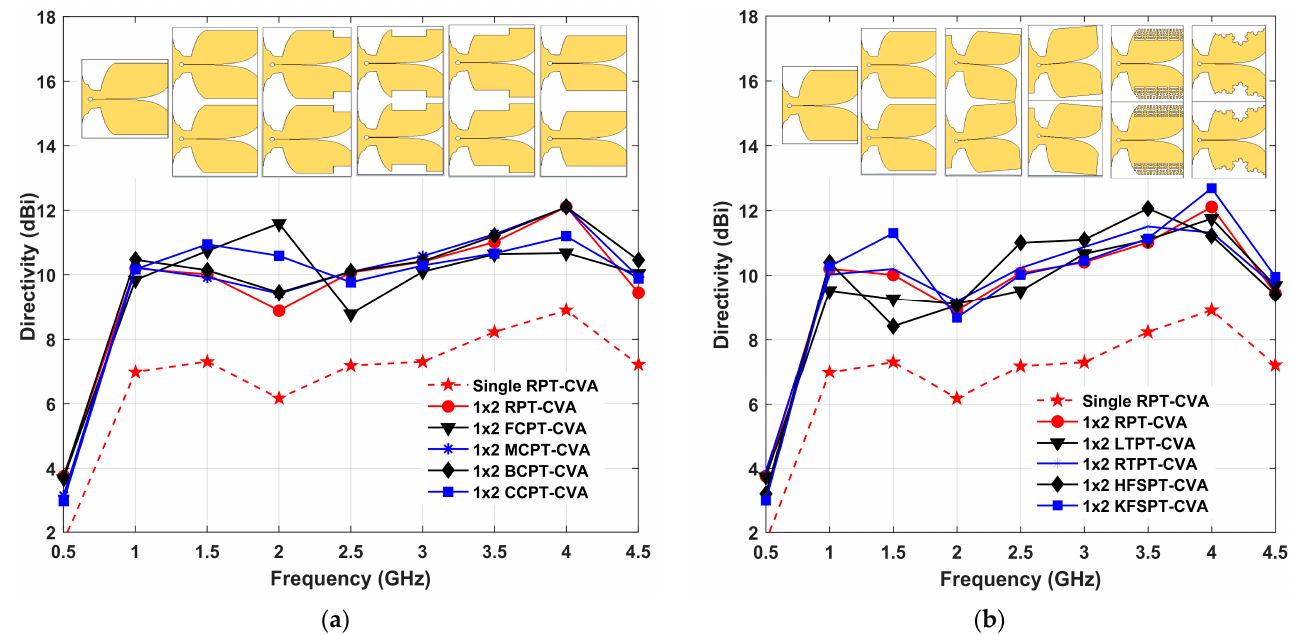
Figure 6. Directivity of: ( a ). Single and 1 × 2 Regular Palm Tree (RPT – CVA), 1 × 2Front Cut Palm Tree (FCPT–CVA), 1 × 2 Middle Cut Palm Tree (MCPT–CVA), 1 × 2 Back Cut Palm Tree (BCPT – CVA), 1 × 2 Complete Cut Palm Tree (CCPT–CVA) and ( b ). Single and 1 × 2 of Regular Palm Tree (RPT – CVA), 1 × 2 Left Tilt Palm Tree (LTPT–CVA), 1 × 2 Right Tilt Palm Tree (RTPT – CVA), 1 × 2 Hilbert Fractal Structure Palm Tree (HFSPT – CVA), 1 × 2 Koch Fractal Structure Palm Tree (KFSPT–